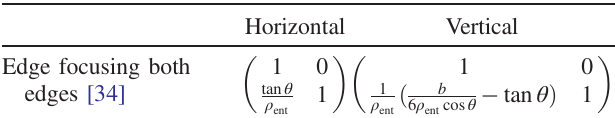
TABLE II. Focusing/defocusing components in the bending